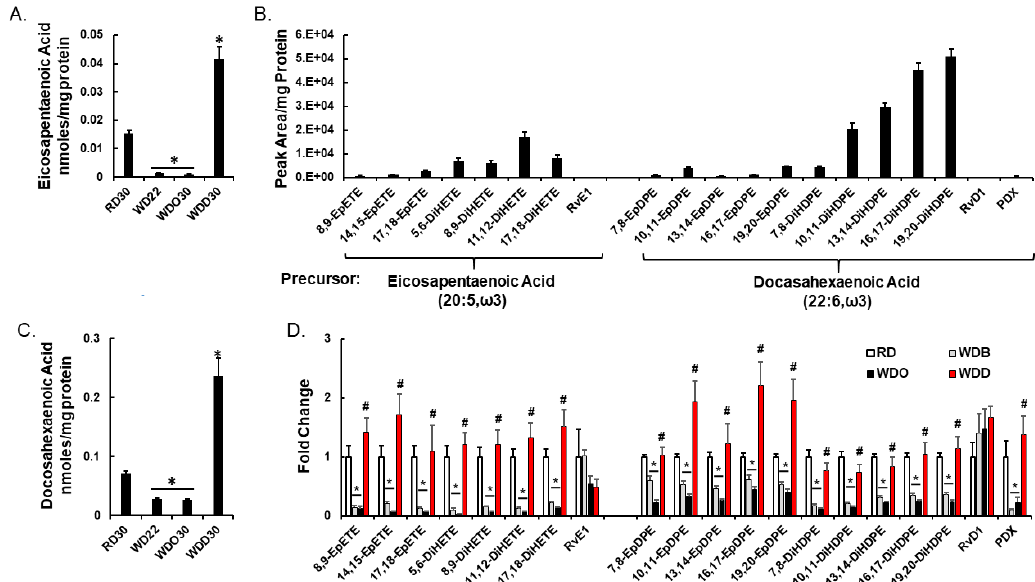
Figure 6. Diet effects on oxylipins derived from ω 3 PUFA. Hepatic content of eicosapentaenoic acid (EPA; 20:5, ω 3) (Panel A ) and docosahexaenoic (DHA; 22:6, ω 3) (Panel C ). Hepatic EPA and DHA were quantified as described in the Materials and Methods Section and presented as the mean ± SEM of nmoles / mg hepatic protein. (Panels B , D ): Effects of diet on EPA and DHA derived oxylipins, respectively. Results are presented as Peak area / mg protein (Panel B ) and Fold Change, mean ± SEM (Panel D ). *, q < 0.05 vs. RD30; #, q < 0.05 vs.